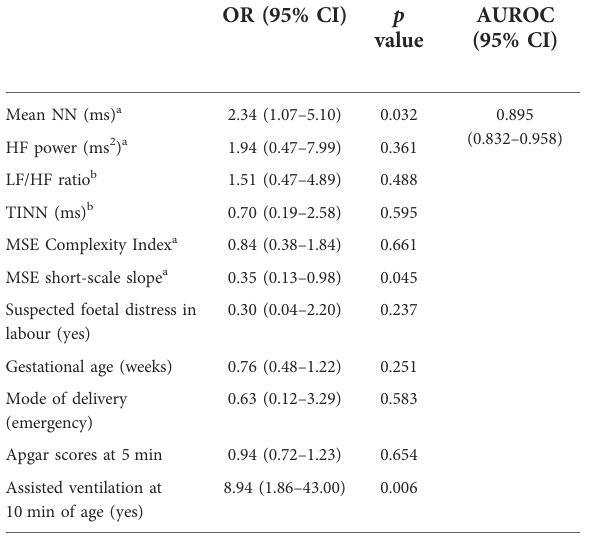
TABLE 6 HRV and clinical prediction model, n =101 infants.